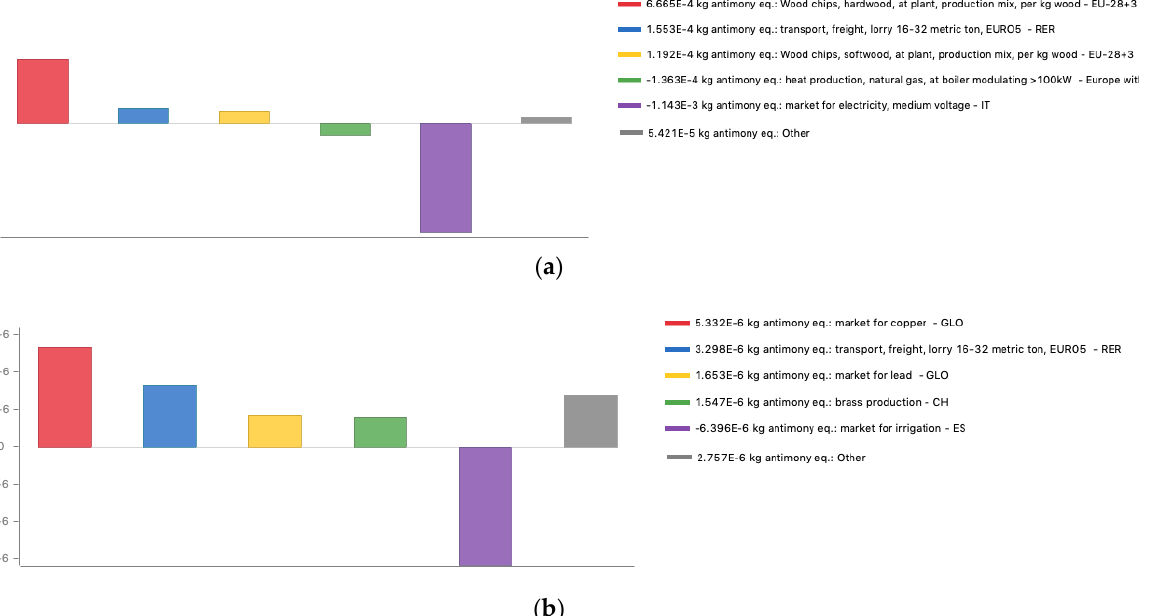
Figure 5. Depletion of abiotic resources—elements, ultimate reserves: top 5 contributions impacting category results: ( a ) Cradle-to-grave analysis; ( b ) Downstream process.